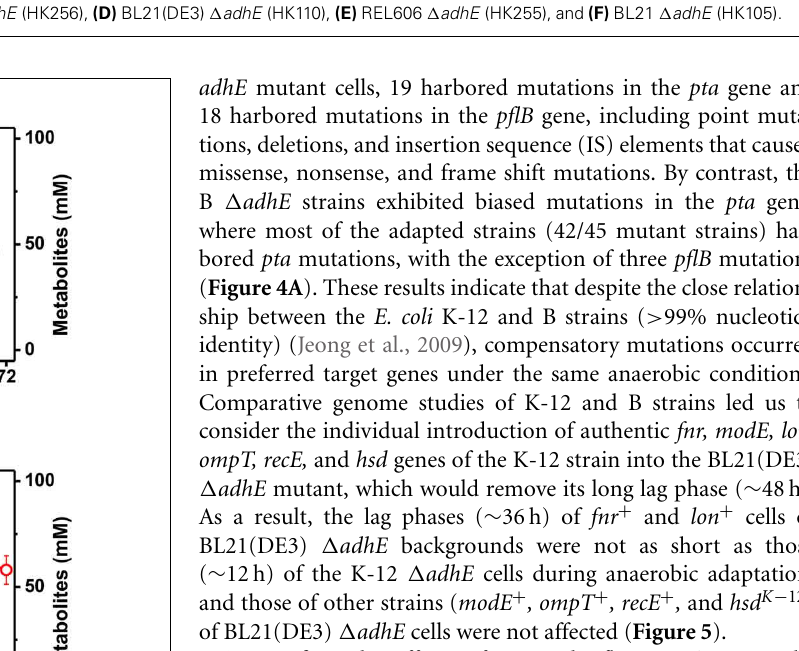
sequences of the pta and pflB genes of the adapted progeny strains by Sanger